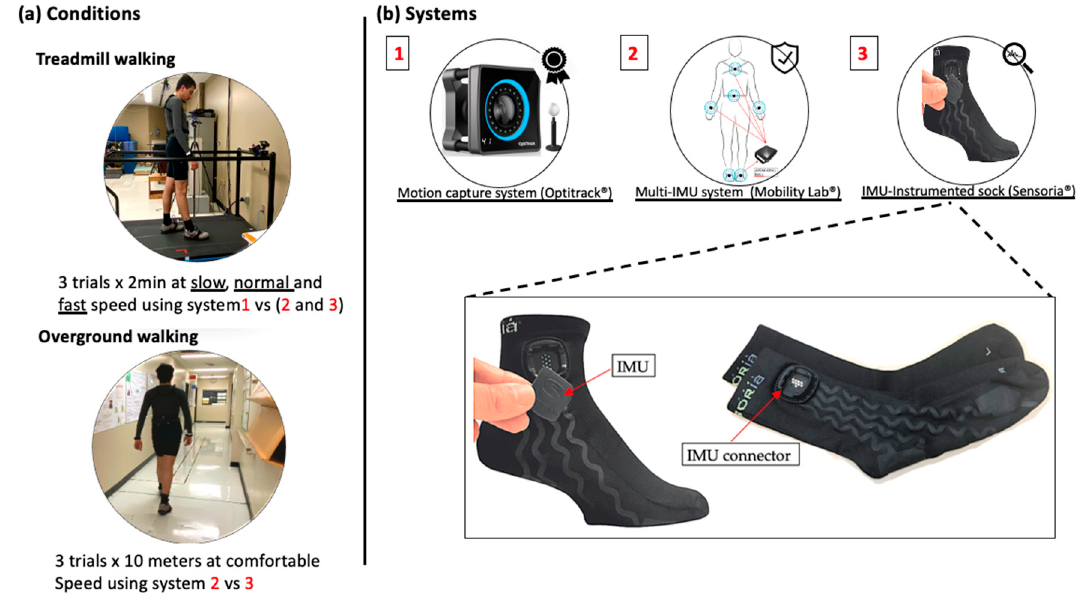
Figure 1. Conditions and measurement systems used for data acquisition. ( a ) Participants performed three 2 min treadmill walking trials at slow, normal, and fast walking speeds and three 10 m overground walking trials at a self-selected comfortable speed. ( b ) A motion capture system was used as the gold standard to validate the estimations of the spatio-temporal parameters for treadmill walking based on the IMU-instrumented sock and the Mobility Lab